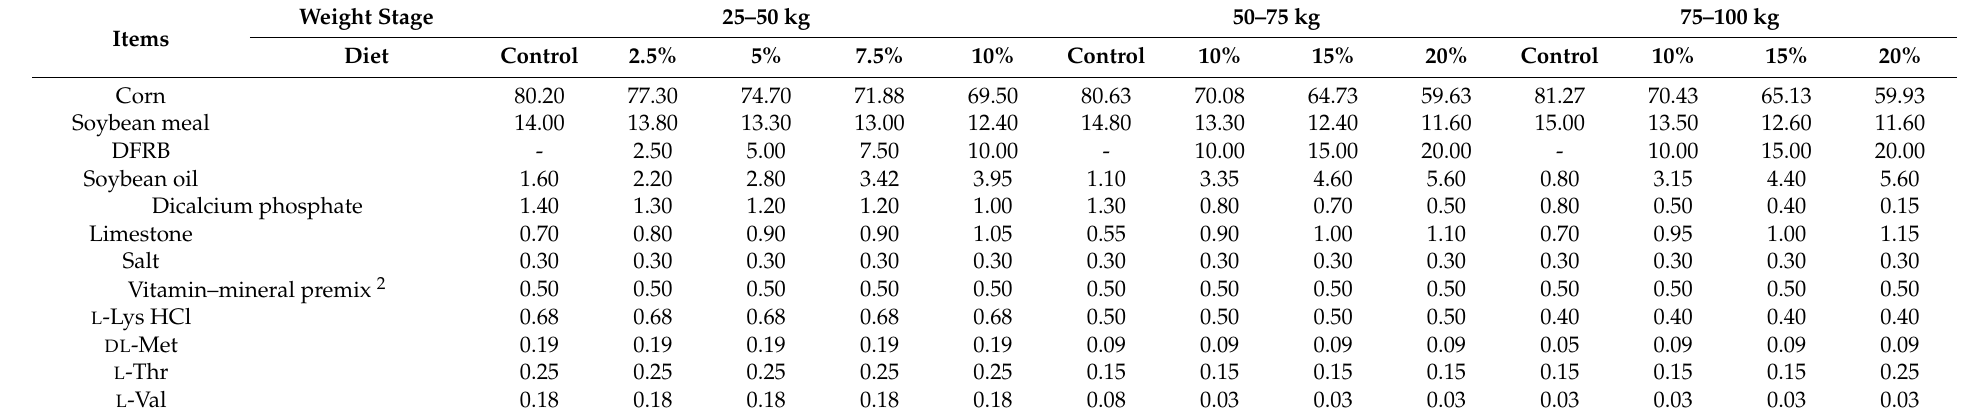
Table 1. Ingredient composition of the experimental diets (%, as-fed basis) 1